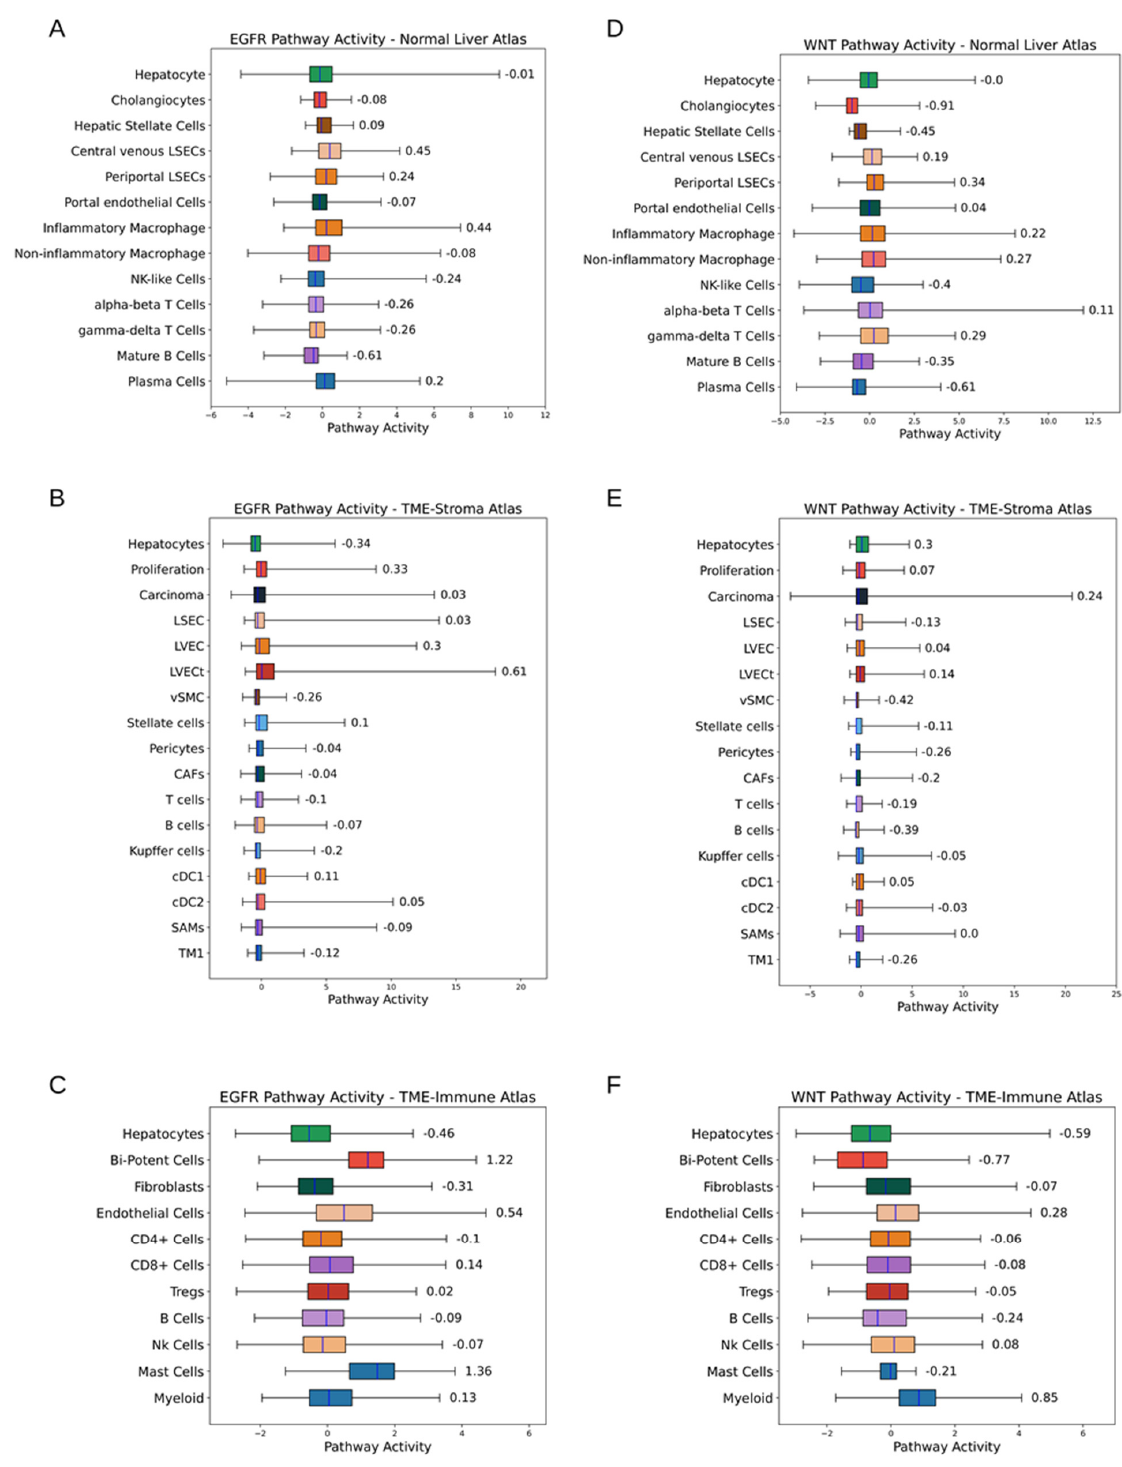
Figure 8. Pathway activities of cell types in the three atlases (estimated by PROGENy). ( A – C ) EGFR activities. Central venous LSECs, inflammatory macrophages, LVECt, bi-potent cells, mast cells, etc., are EGFR active, suggesting the involvement in angiogenesis, immune responses, and proliferation. ( D – F ) WNT activities. Periportal LSECs, inflammatory and non-inflammatory macrophages, gamma-delta T cells, hepatocytes (TME-Strom), carcinoma cells (TME-Stroma), myeloid cells, etc., are WNT active, suggesting the involvement in immune